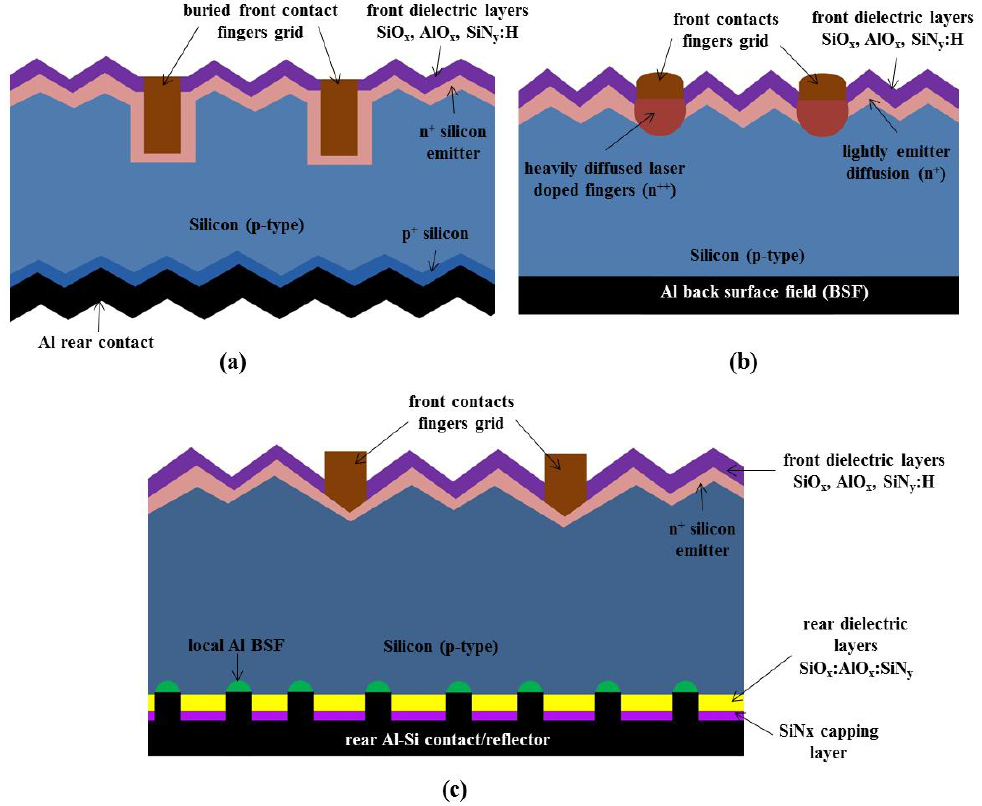
Figure 10. Solar cell structures most commonly adopted for Ni/Cu based metallization scheme. ( a ) Laser doped buried contact (LDBC) cell; ( b ) Laser doped selective emitter (LDSE) cell; ( c ) Passivated emitter rear cell